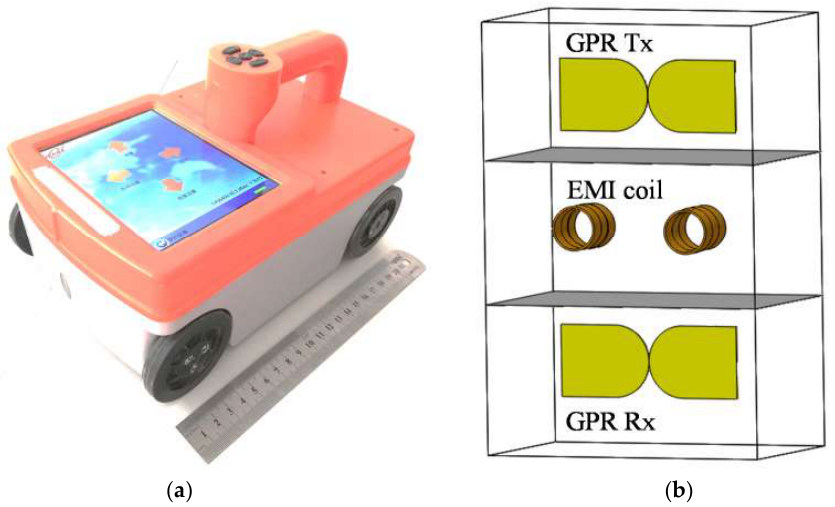
Figure 1. ( a ) Photo of the prototype of the developed rebar detection system, and ( b ) schematic structure of GPR antennas and EMI coils inside the apparatus.